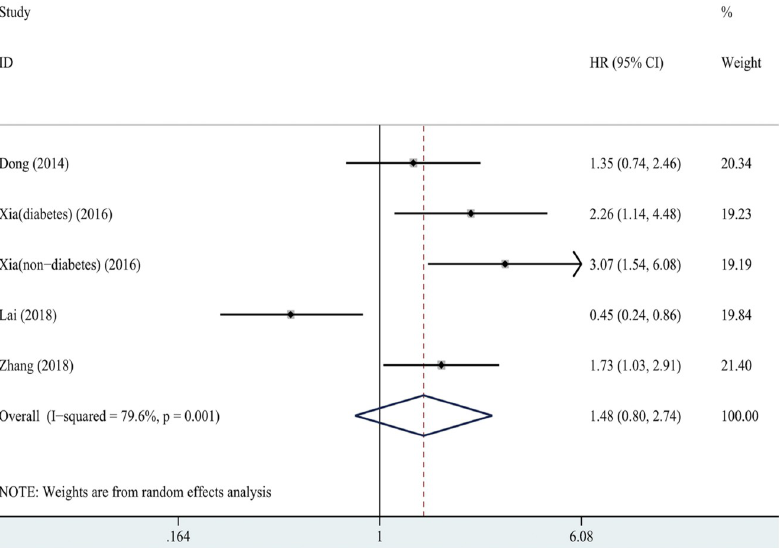
Fig 3. Forest plot for relationship between SUA and cardiovascular mortality in PD patients. The highest SUA category versus the lowest. SUA, serum uric acid; PD, peritoneal